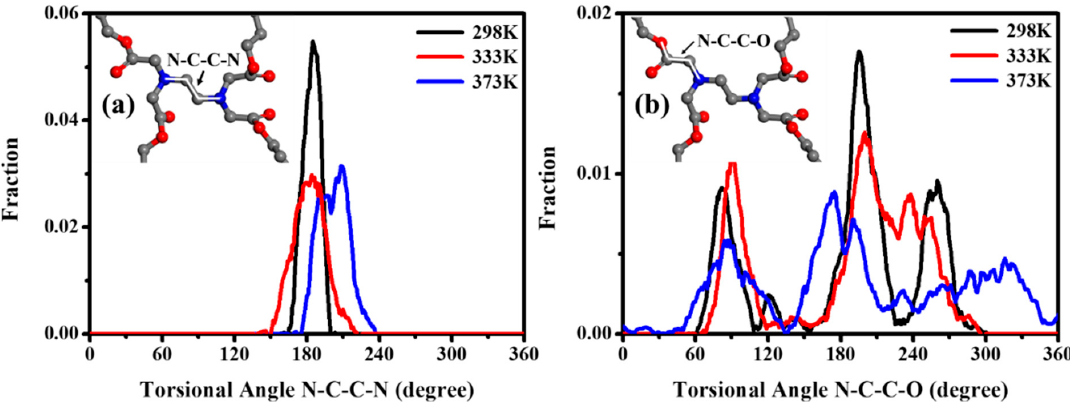
Figure 10. The torsional angle distribution of ( a ) N–C–C–N within the EDTA and ( b ) N–C–C–O between the EDTA and the